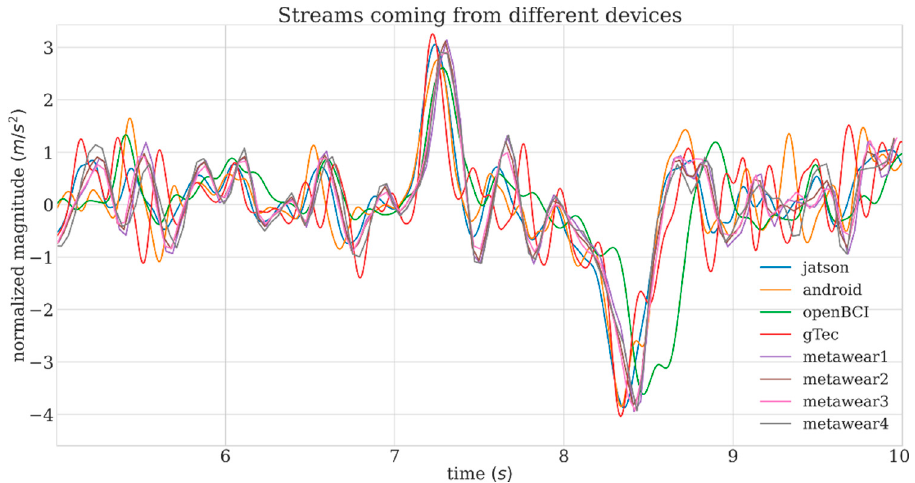
Figure 5. Example of accelerometer LSL-streams coming from different devices, before initial offset compensation.